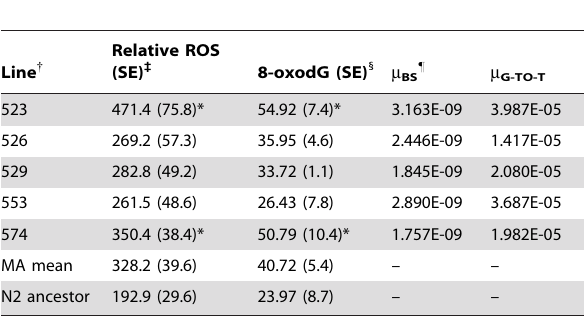
Table 1. Estimates of oxidative stress and mutation